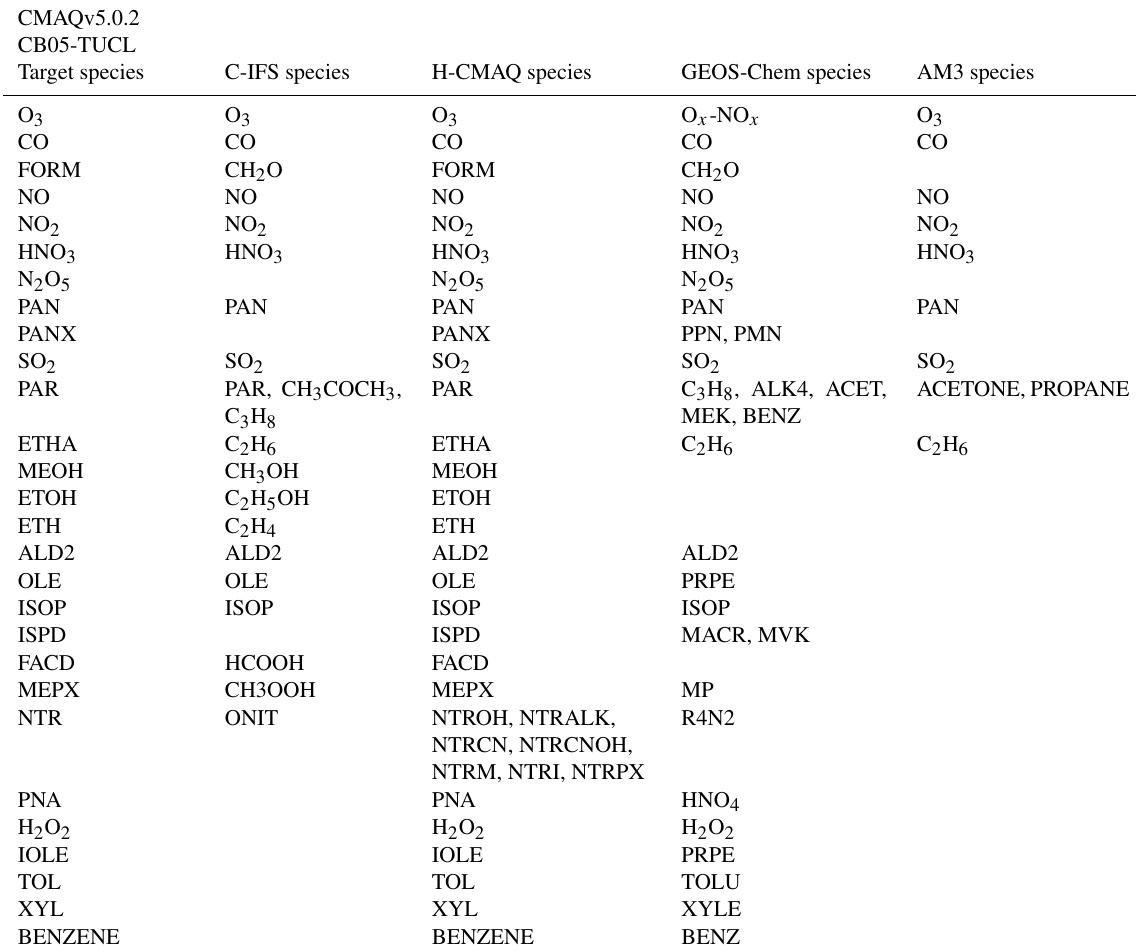
Table 1. Mapping of gas-phase species from C-IFS, H-CMAQ, GEOS-Chem, and AM3 to regional-scale CMAQ.